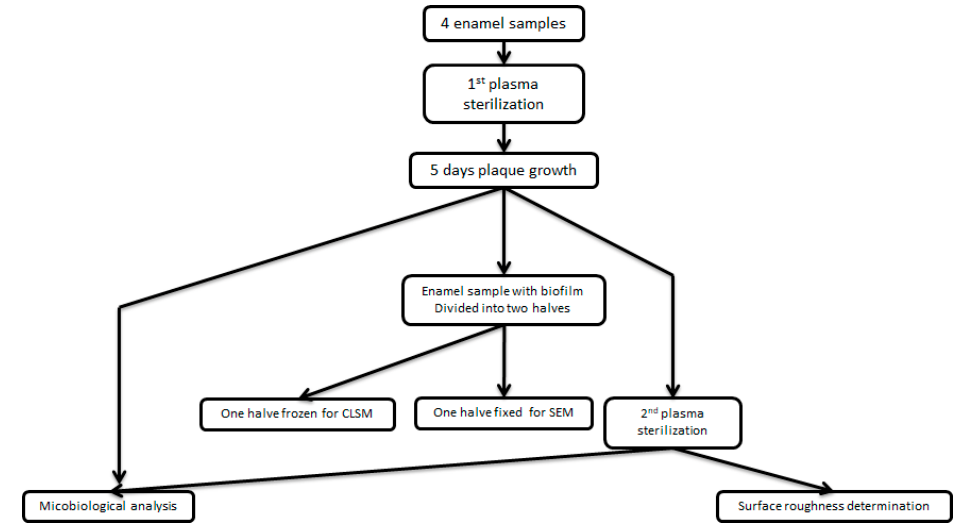
Figure 1. Work flow of the study protocol.